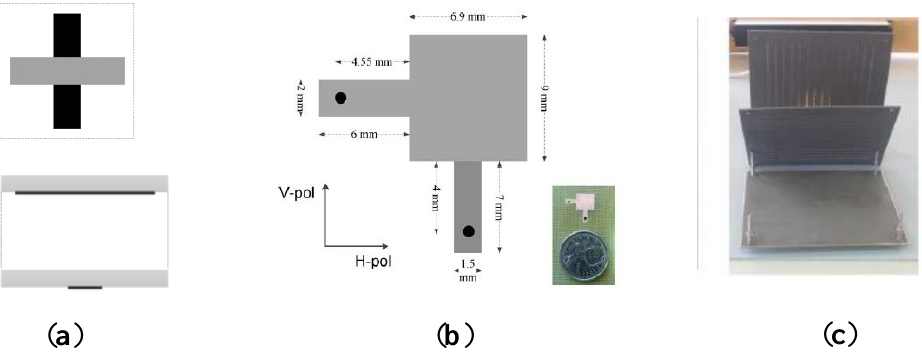
Figure 19. Configuration of the design in [159]: ( a ) Unit cell; ( b ) Main radiator; ( c ) Entire RCA